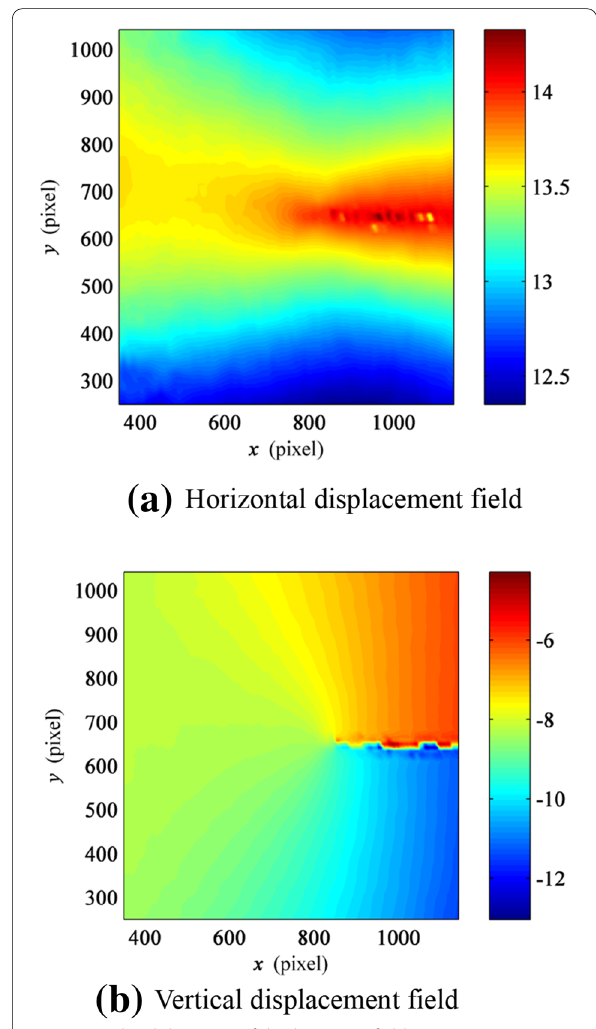
Figure 4 Cloud diagrams of displacement fields